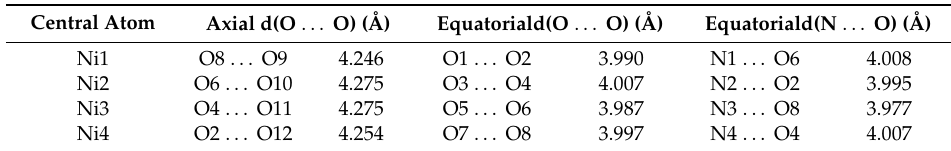
Table 5. Ni local geometry in [Ni 4 ] from the X-ray structure [3]: distance between opposite atoms of the NiO 5 N octahedral.